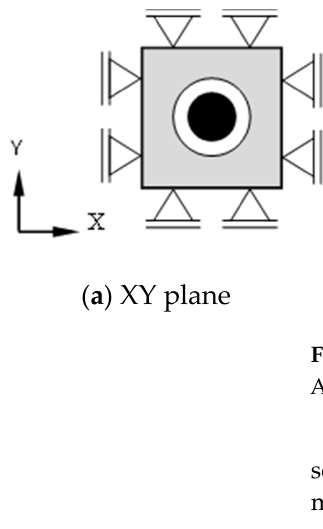
Figure 6. Boundary conditions of the 3D FE-Model ( a , b ): illustrative presentation, ( c ) Model in Abaqus.